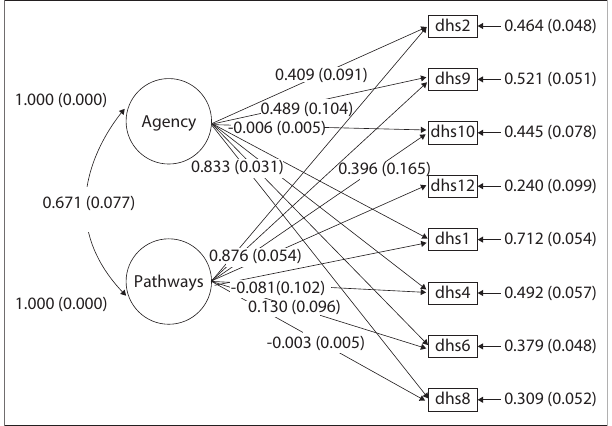
FIGURE 4 : The exploratory structural equation modelling two-factor solution for sample 2 ( n = 251).